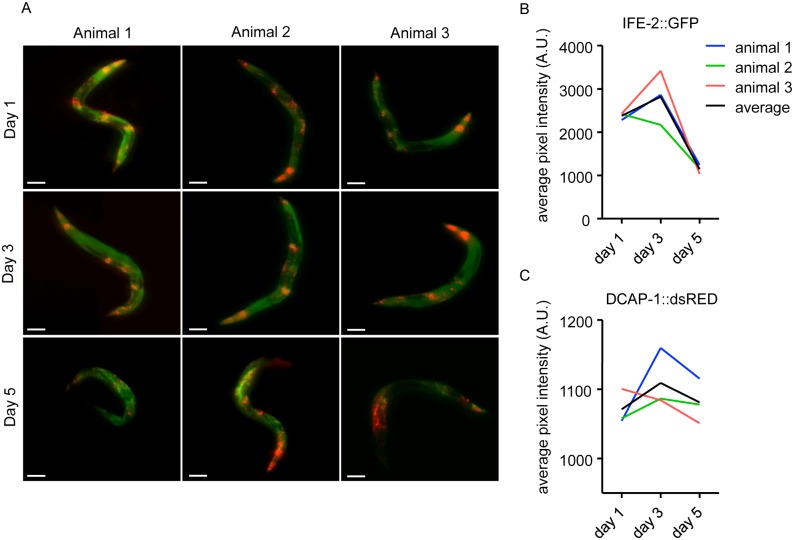
Protein dynamics in a longitudinal ageing study in C. elegans.(A) Representative images of 3 single animals grown at 25°C at day 1, 3 and 5. Animals co-express pife-2IFE-2::GFP and pdcap-1DCAP-1::dsRED (see S4 Video). Individuals show differences in protein localization during ageing. Size bars correspond to 100μm. (B) IFE-2::GFP and (C) DCAP-1::dsRED fluorescent intensity quantification of the 3 animals in (A).